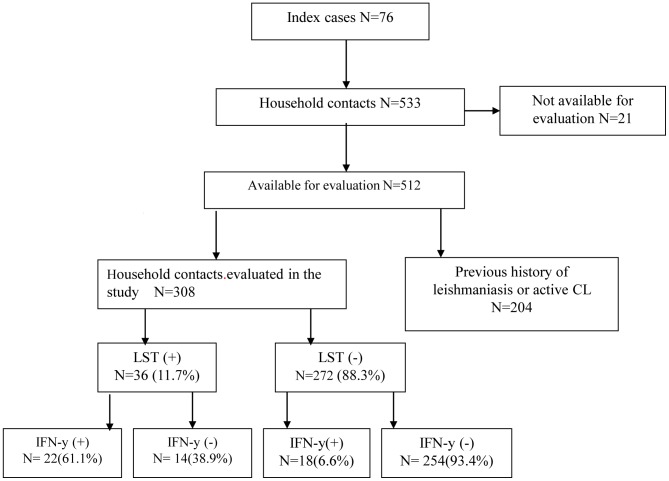
Establishment of a cohort of HC of CL patients in L. braziliensis endemic area.